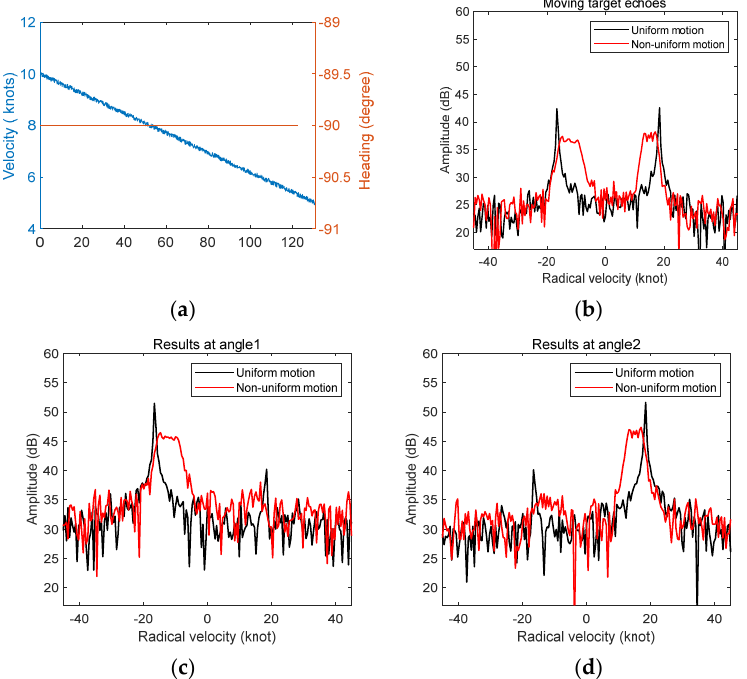
Figure 6. Simulation results of target echo in case of uniform deceleration linear motion: ( a ) the distribution of the velocity and heading of the platform, ( b ) channel result, ( c ) beam result at range1, ( d ) beam result at range2.